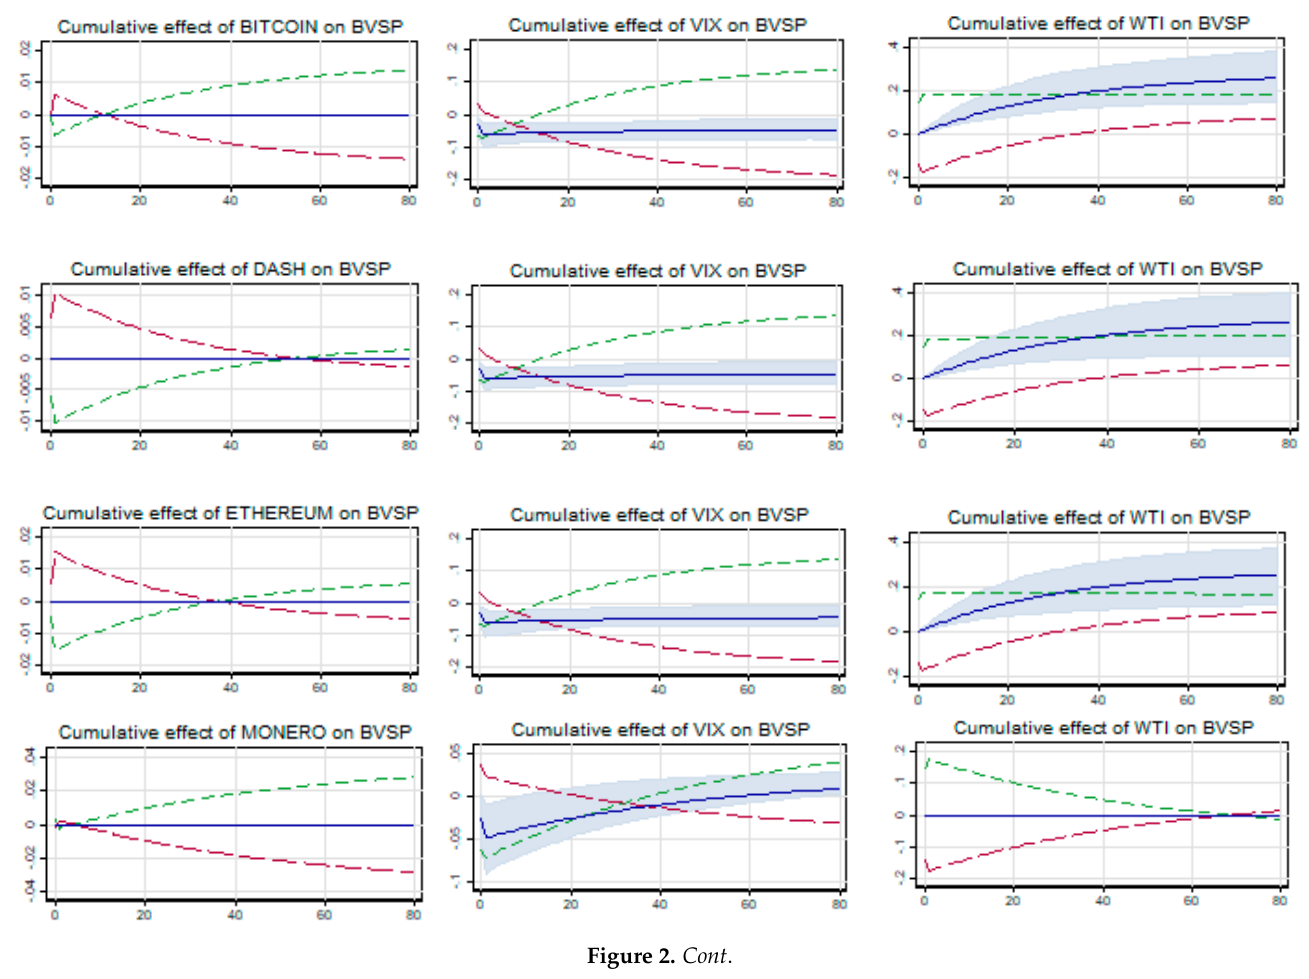
Figure 2. Cumulative effects of cryptos and gold on BVSP. 4.1.3. JSE 40 The pre-crisis relationship is symmetric between JSE 40 and three cryptocurrencies, namely, Ethereum, Monero, and Ripple, and gold both in the long and short run as seen from the results in Table 7. However, for Bitcoin and Dash it is symmetric (asymmetric) in the short (long) run. The long-term cointegrating coefficient (LX) is positive and signif- icant across all five cryptocurrencies, thus declining any safe haven opportunity. How- ever, gold is found to be a weak safe haven as the long-term cointegrating coefficient (LX) is negative but not significant. As far as sustainability of the long-term cointegrating rela- tionship is concerned, it is unsustainable as evidenced from the cumulative graph in Fig- ure 3 for all five cryptocurrencies including gold. Table 7. Estimation results for JSE 40 before COVID-19. 𝑿 = 𝑩𝒊𝒕𝒄𝒐𝒊𝒏